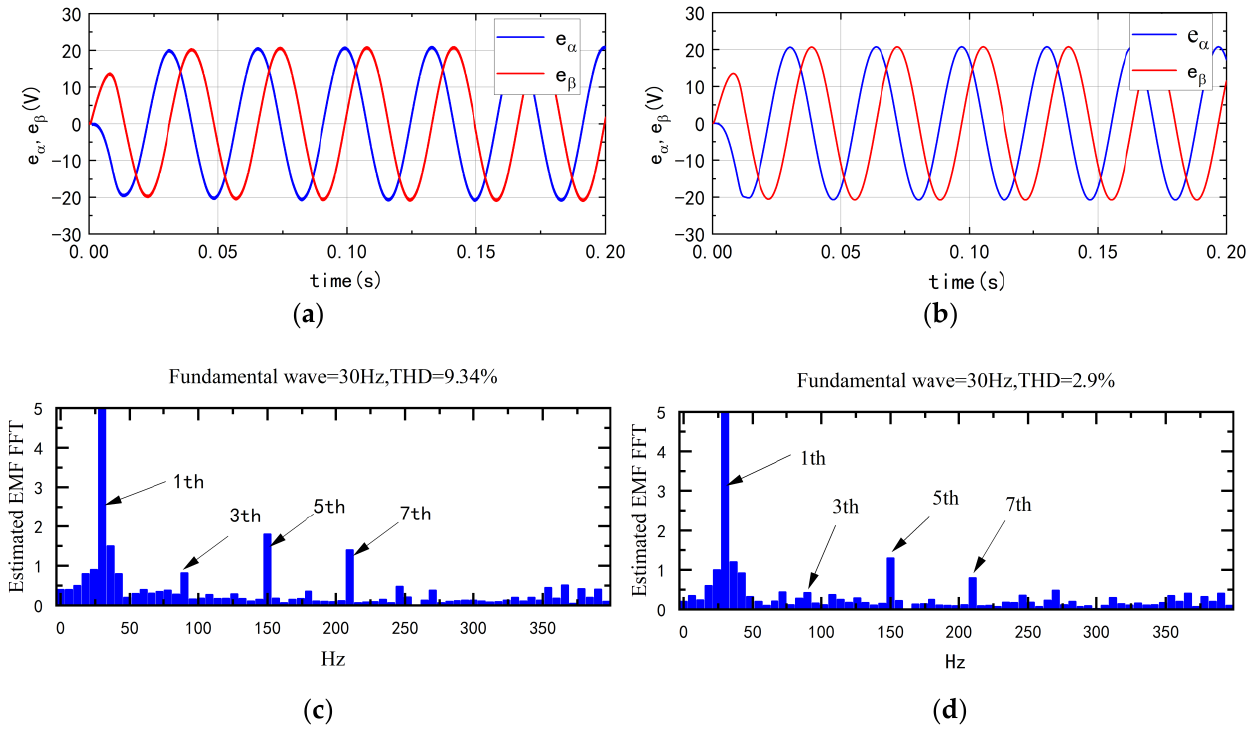
Figure 12. Back EMF waveform at low speed; ( a ) back EMF with traditional SMO control; ( b ) back EMF with improved SMO control; ( c ) traditional SMO simulation back EMF FFT analysis; ( d ) improved SMO simulation back-EMF FFT analysis.